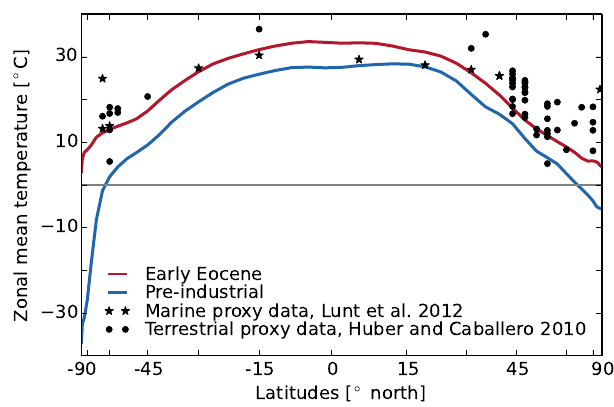
Figure 1. Zonal annual mean 2m temperature in the DE d simu- lation (red line) and in the DP d simulation (blue line). Stars show estimates of annual mean sea-surface temperature (SST) and near- surface temperature for the early Eocene based on δ 18 O, Mg / Ca, and TEX 86 (Lunt et al., 2012). Cycles refer to terrestrial annual mean temperature estimates based on macrofloral and palynoflora assemblage data and from teeth, hydrogen isotopes, and oxygen iso- topes (Huber and Caballero,